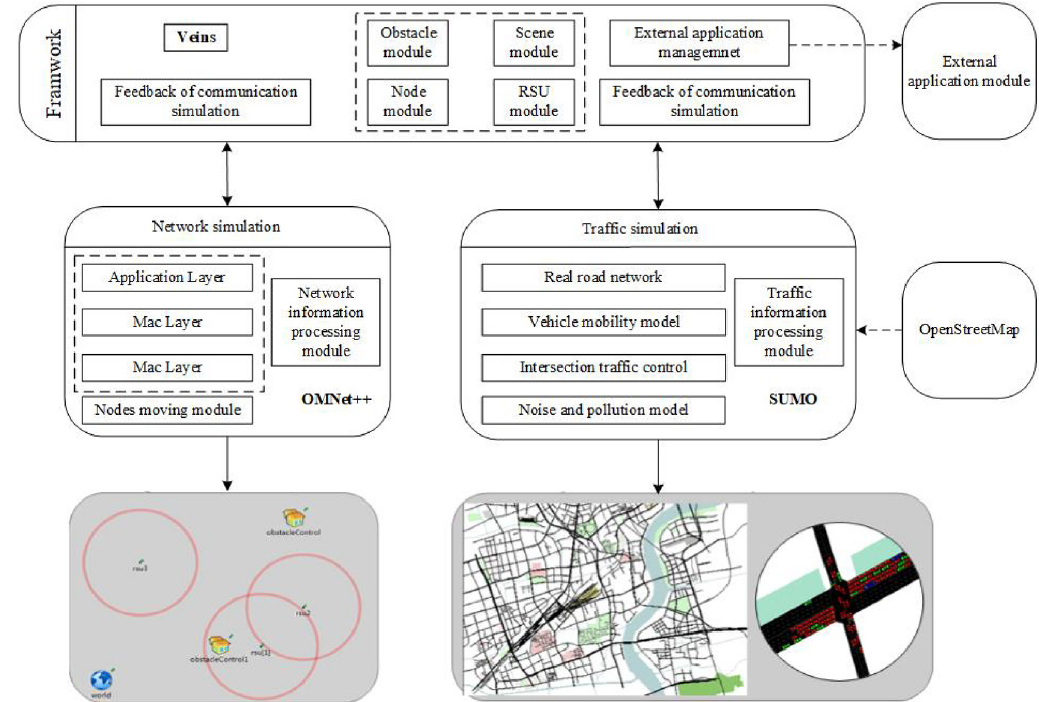
Figure 1 Structure of VANET simulation